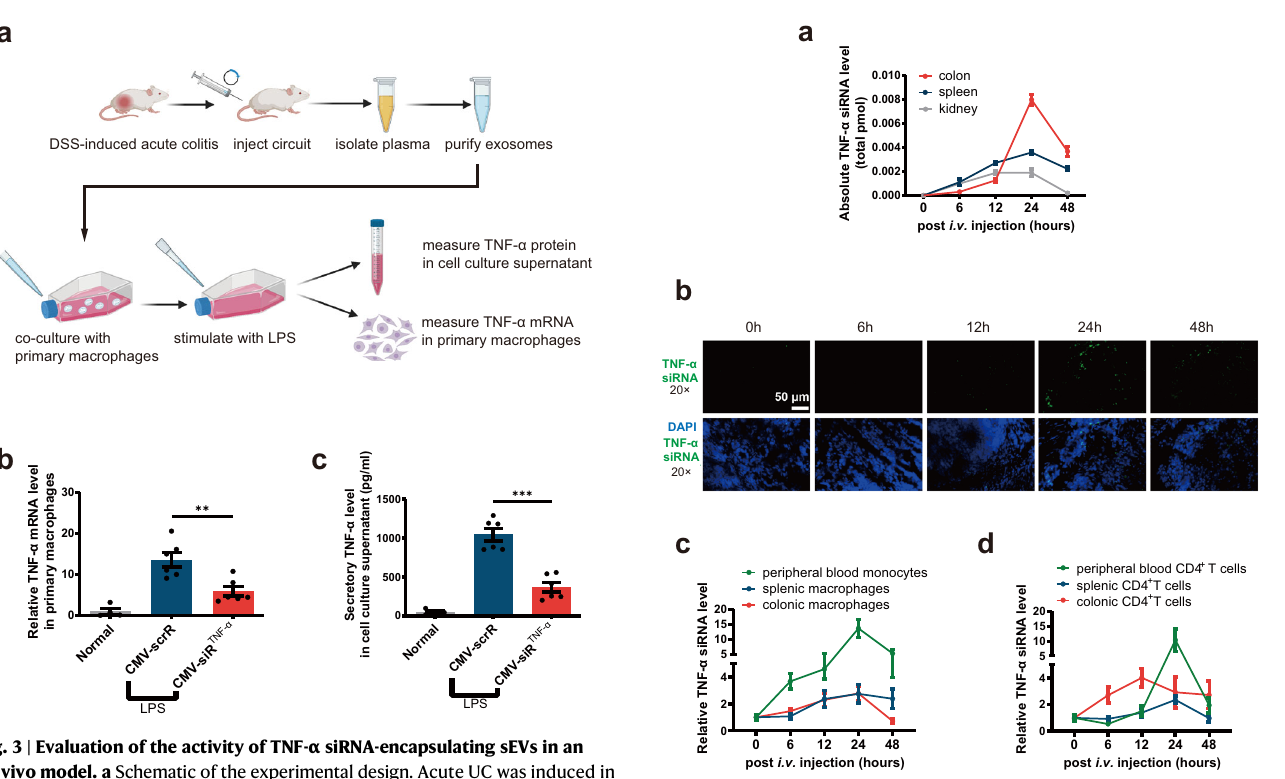
Fig.4 |Trackingofthedeliveryofself-assembledTNF- α siRNAtoimmunecells in in fl amed mucosa. a Kinetics of TNF- α siRNA in the mouse colon, spleen and kidneyfollowingtailveininjectionof the5mg/kgCMV-siR TNF- α circuit( n =3ineach group). The total TNF- α siRNA levels in the colon, spleen and kidney were calcu- lated based on the totalamount ofRNA isolated from one gram of each tissue and theTNF- α siRNAcontentinone μ goftotalRNA. b InsitudetectionofTNF- α siRNA in colon sections of DSS mice at 0, 6, 12, 24 or 48h after injection with the CMV- siR TNF- α circuit. Positive in situ hybridisation signals are shown in green, and DAPI- stained nuclei are shown in blue. Scale bar: 50 μ m. c Kinetics of TNF- α siRNA in monocytes and macrophages derived from peripheral blood, spleen and colonic laminapropriaof DSSmicefollowing tailveininjection of the5mg/kgCMV-siR TNF- α circuit( n =3ineachgroup). d KineticsofTNF- α siRNAinCD4 + Tcellsderivedfrom peripheralblood,spleenandcoloniclaminapropriaofDSSmicefollowingtailvein injection of the 5mg/kg CMV-siR TNF- α circuit ( n =3 in each group).